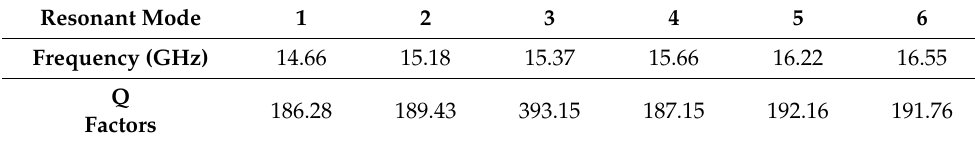
Table 1. The simulated frequency and Q factors of the resonant modes inside the cavity.